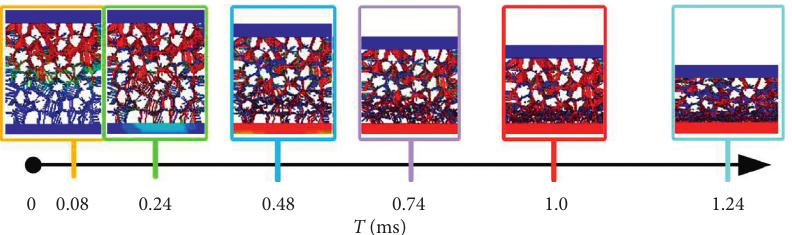
Figure 9: Compressed foam aluminum cover.